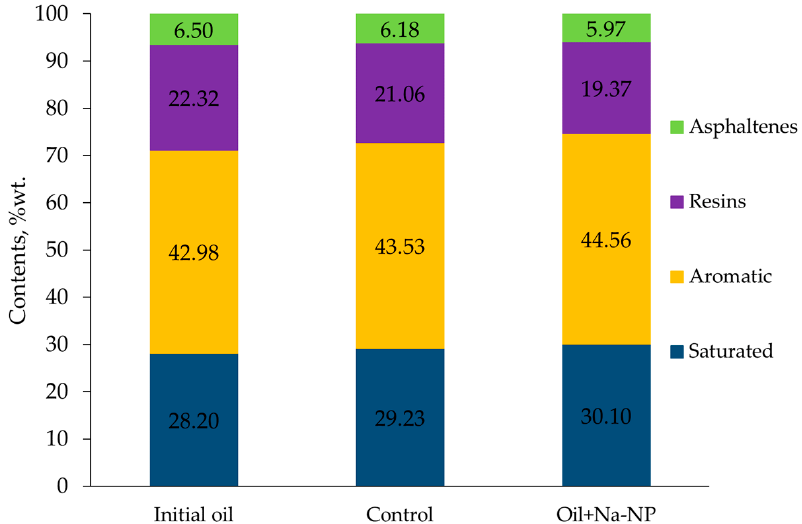
Figure 3. Fractional composition of oil before and after processing.